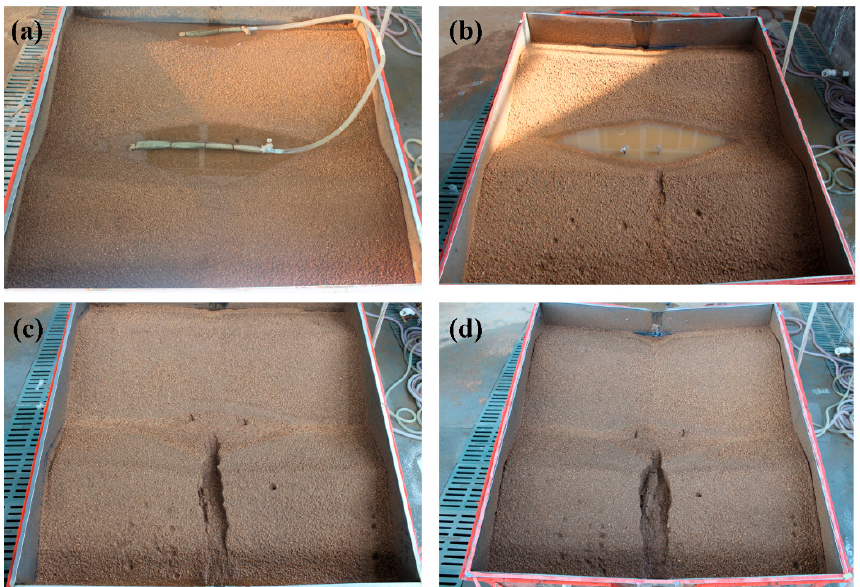
Figure 3. Soil surface morphology before and after rainfall experiments. ( a ) before rainfall; ( b ) inter-rill and headward erosion process; ( c ) contour failure; ( d ) rill erosion.